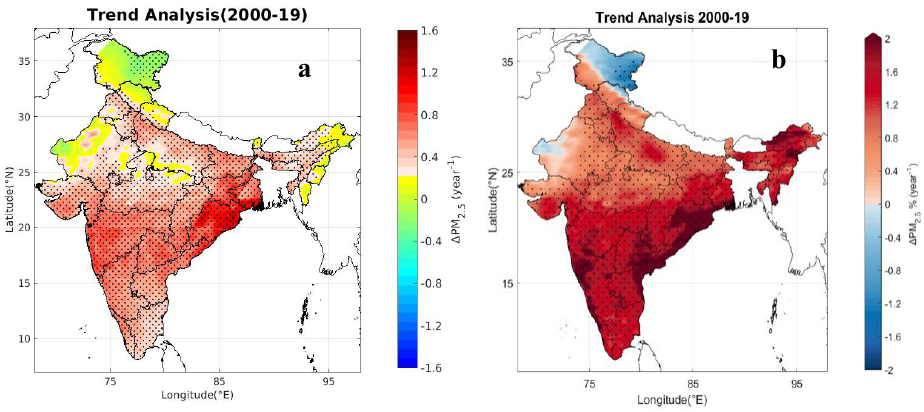
Figure 9. Spatial patterns of ( a ) the annualized rate of changes in PM 2.5 (in µ g / m 3 per year) and ( b ) the relative changes (in % per year) over India during the 20 years. The statistically significant trends (p<0.05) are identified as stippled marks.